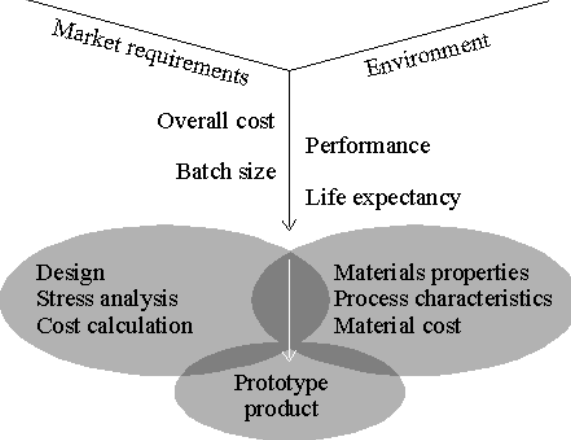
Figure 1. The interactions between design, product and materials selec-